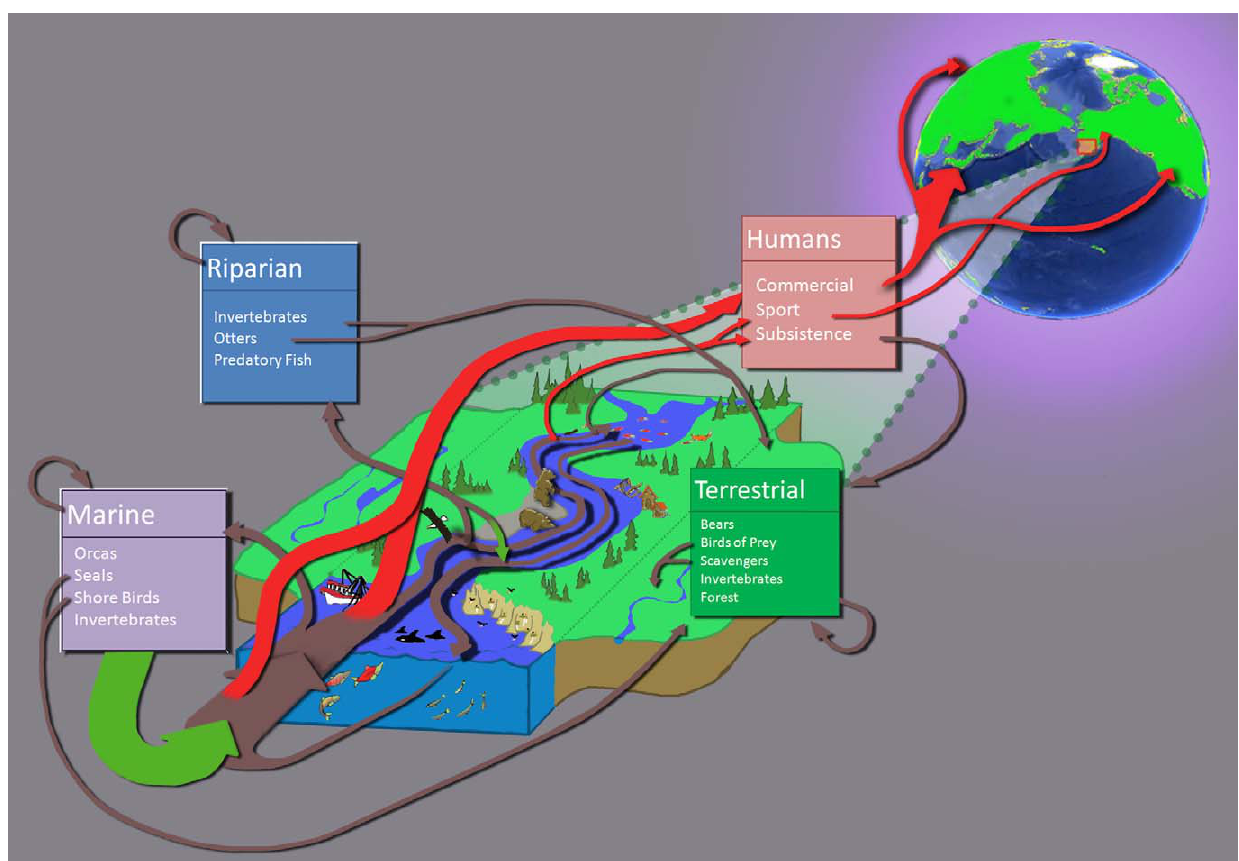
Figure 1. Pictorial illustration of important flows of salmon and contained biomass, energy, and nutrients within and out of the Bristol Bay ecosystem. Brown arrows depict the flows within the ecosystem, green arrows depict inputs due to growth in fresh water or the sea, and red arrows represent human harvest. Seventy percent of salmon are extracted by humans and are no longer available to the Bristol Bay ecosystem.